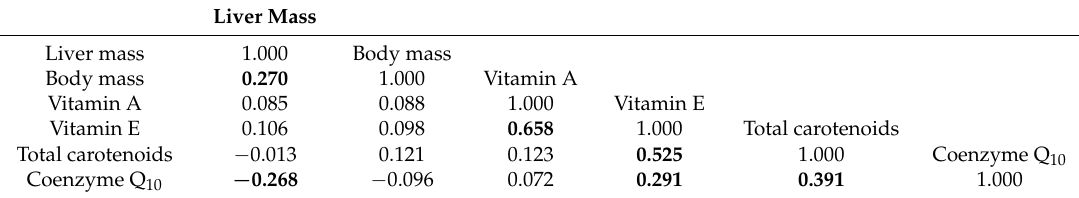
Table 2. Pearson product-moment correlation coefficients between liver mass, body mass, and concentration ( µ g/g) of antioxidants in livers of common eiders. Numbers in bold are statistically significant at the 0.05 level. The sample size was 162